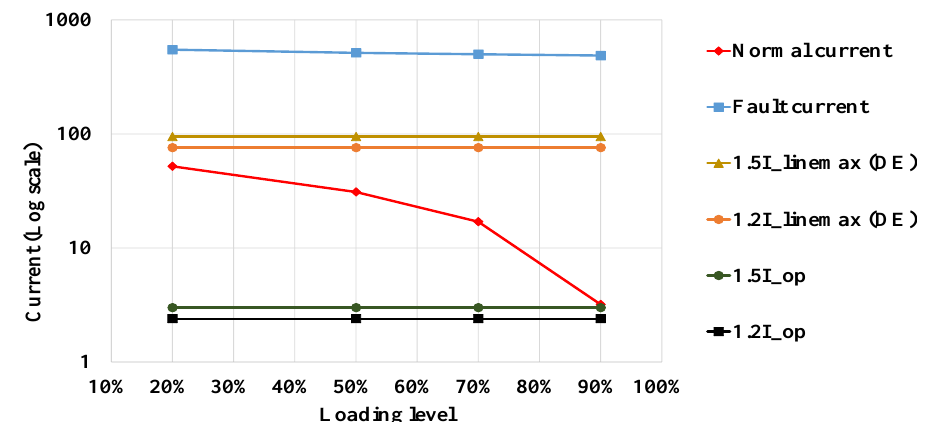
Figure 14. Fault condition under different loading levels with 95% of line and 1 Ω fault resistance.